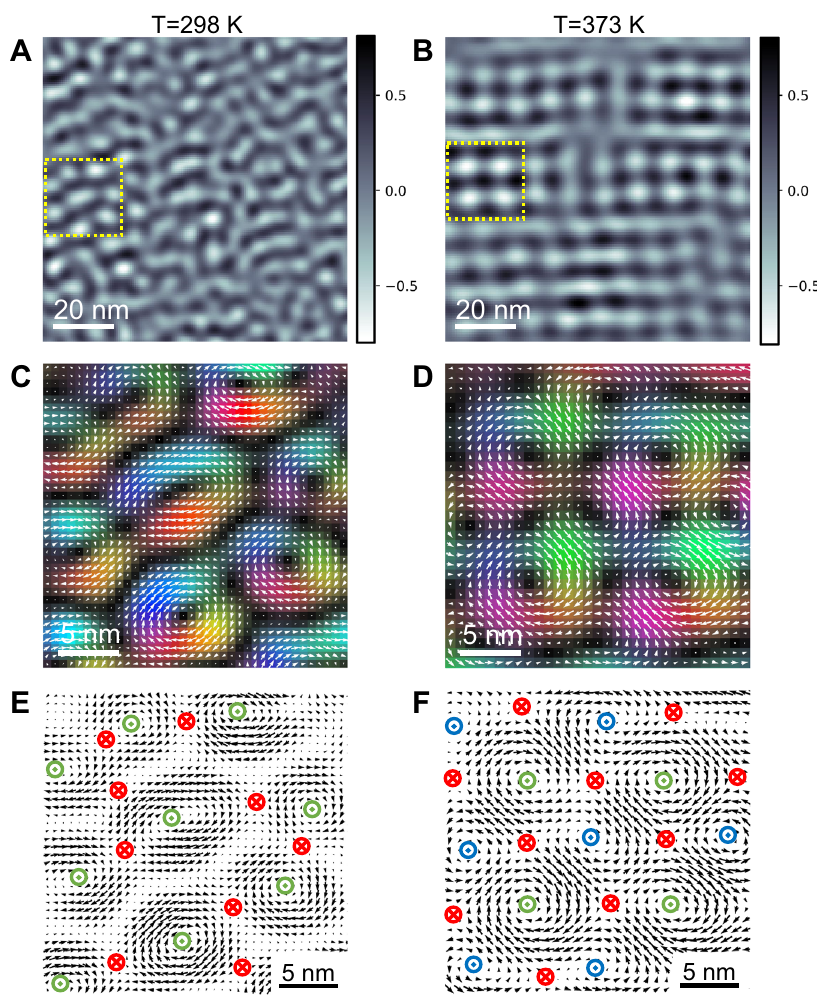
Fig. 4 | Real-space observations of disordered polar skyrmions and a square respectively exhibiting the skyrmion texture at 298K and local ordered meron * * lattice of merons. The curl of in-plane polarization ( ∇ textures at 373K. E , F Details of ( C , D ), where vortices (clockwise: green, counter- × P ) [001] showing the rota- clockwise: blue) and antivortices (red) are labeled. The dots in circles represent tion directions of the structures at temperatures of ( A ) 298K and ( B ) 373K. C , D Enlargedin-planepolarizationmappingfromtheyellowboxregionofAandB, polarization pointing out of the page, while the cross points into the